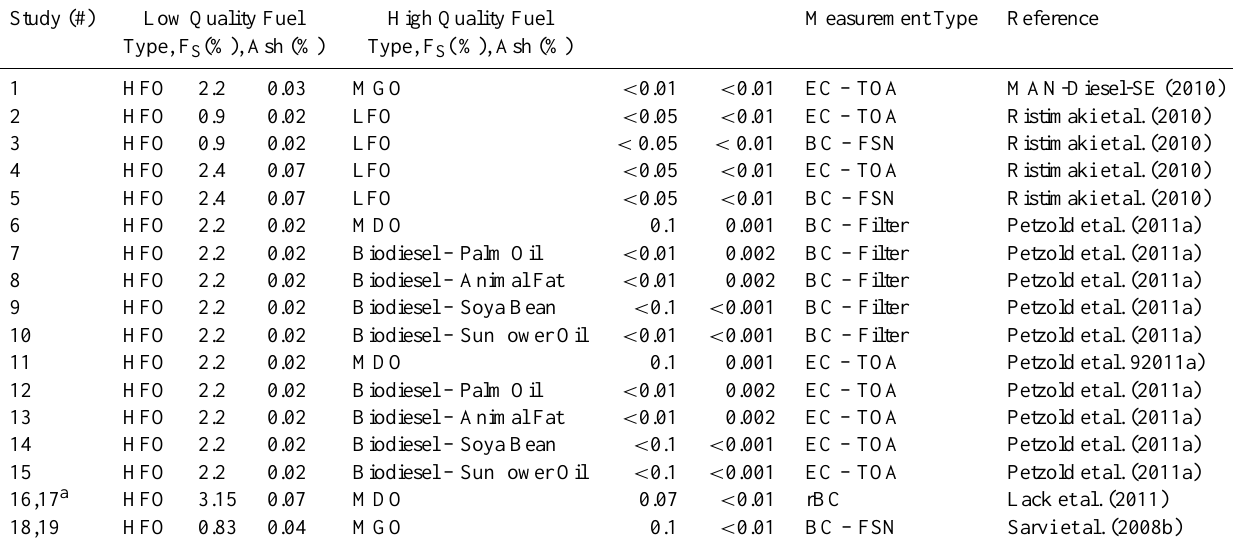
Table 3. Studies on the effect of fuel quality found in literature. Study